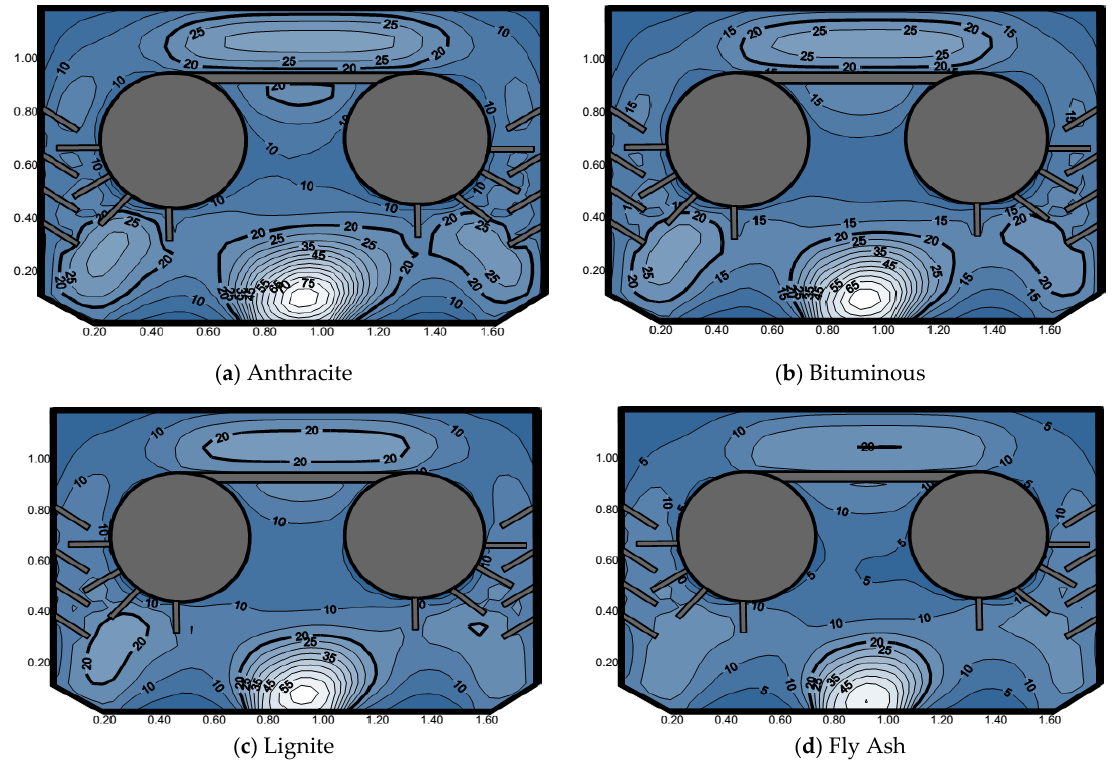
Figure 10. Isothermal profilesfor different particles materials at the plane z = 0.0 m ( x p = 1, ω = 0.9, κ = 5 m − 1 ). ( a ) Anthracite, ( b ) Bituminous, ( c ) Lignite, ( d ) Fly Ash.